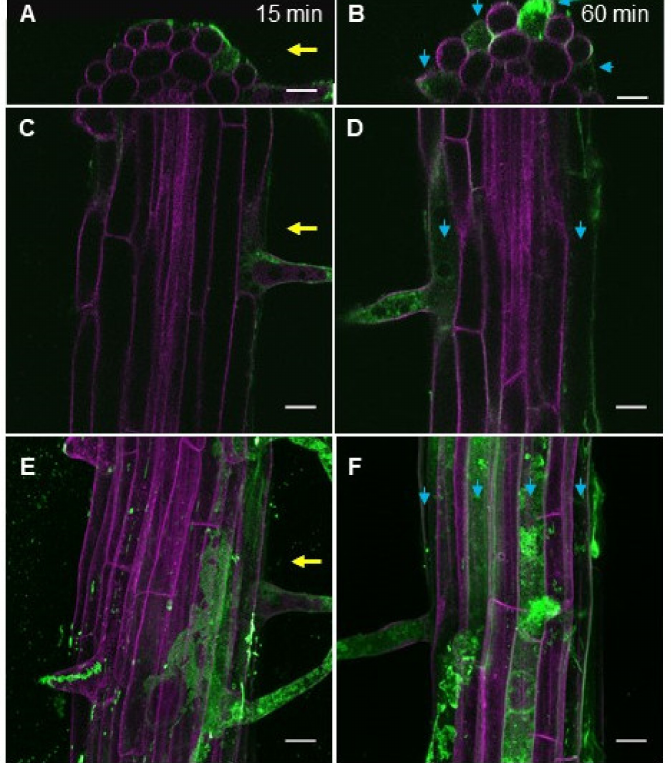
Figure 3. eBL-BODIPY rapidly aggregates with the cell wall and penetrates the epidermal cells. Five-day-old seedlings were placed on solid MS medium containing 0.1 µ M eBL-BODIPY and observed after 15 min ( A , C , E ) and 60 min ( B , D , F ): orthogonal cuts of XZ ( A , B ) and XY ( C , D ) planes, maximum intensity Z-projections ( E , F ); membrane fluorescence (magenta) and BODIPY fluorescence (green). Yellow arrows indicate the root side directly exposed to eBL-BODIPY. Blue arrows point to trichoblast cell lines. Scale bars 20 µ